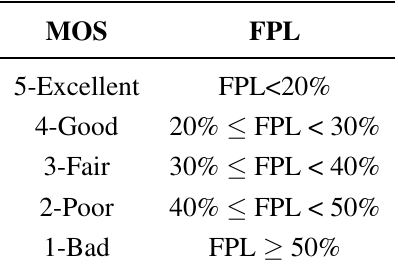
Table 2. Mapping of mean opinion scores (MOS) and fraction of packet losses (FPL) for (I+P) frames in a general MANET